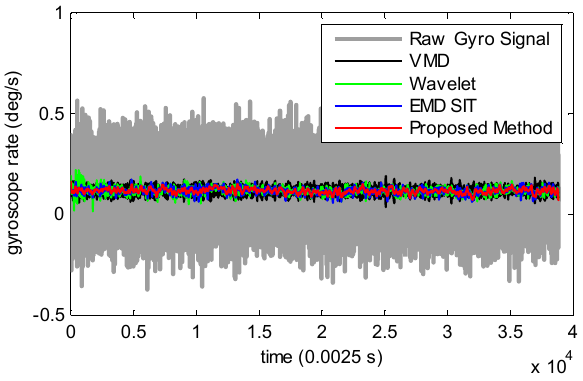
Figure 6. Denoising results of different methods for static motion experiments. Table 1. Results of the micro-electromechanical system (MEMS) gyro signal in static motion experiments. Raw Signal Proposed Method